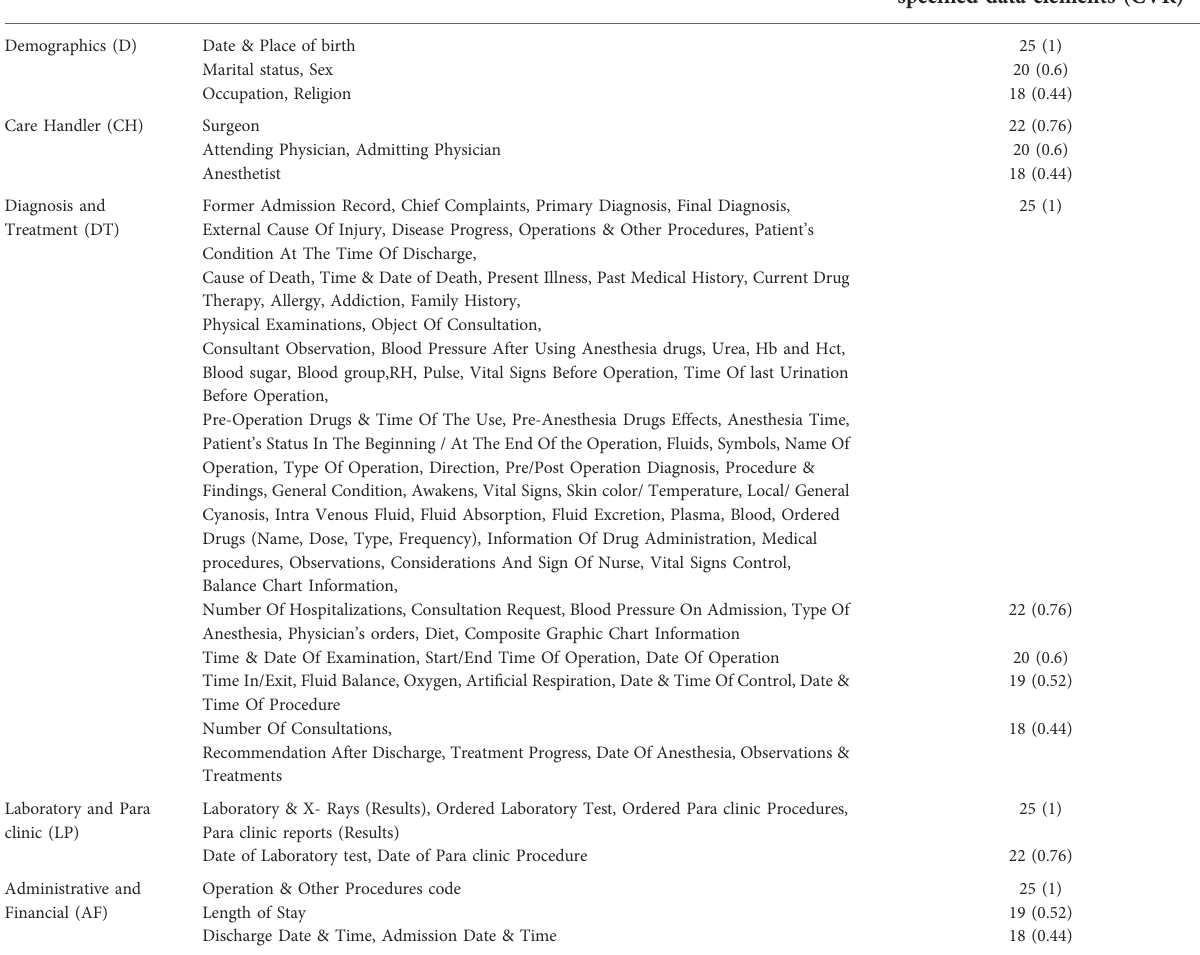
TABLE 1 Content validity ratio (CVR) for research and educational data